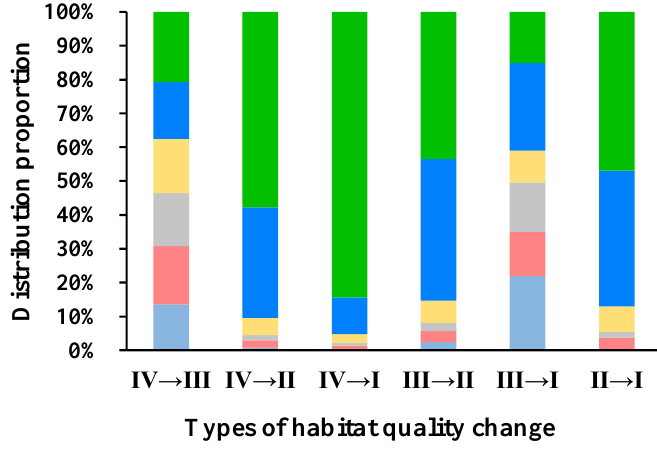
Figure 12. Proportion of habitat quality decreases for different topographic positions.